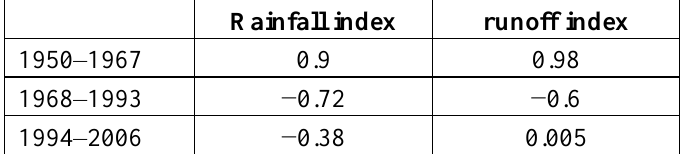
Table 4. Evolution of rainfall and runoff indexes of the Niger River at Niamey station.